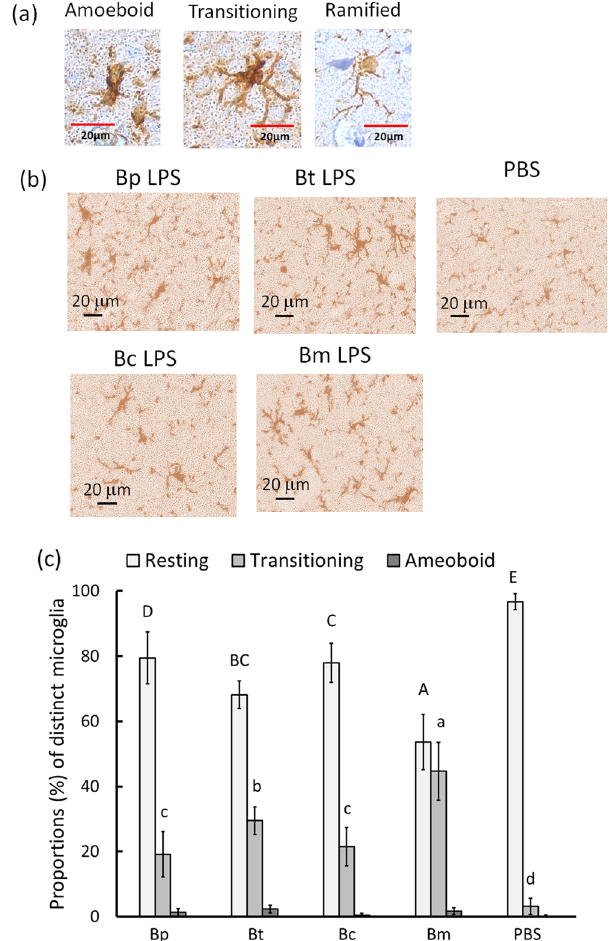
Figure 3. Iba1-expressing microglia. The microglia were categorized as amoeboid, transitioning or ramified, as shown ( a ; 400X ). The Iba1-expressing microglia in the cerebral cortex in four kinds of Burkholder LPS-induced and PBS-treated brains are shown ( b ; 400X ; processed by ImageJ software [H DBA mode]). The proportions of each microglia category out of 100 microglia are shown ( c ). The letters a-d or A-E represent significant differences at p < 0.05 (one-way ANOVA; Tukey’s HSD